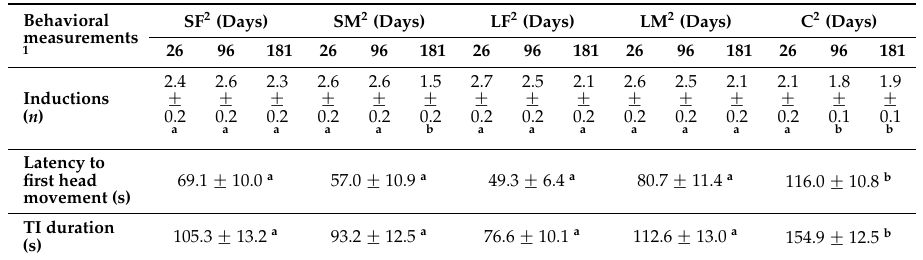
Table 3. Tonic immobility responses of layers when 26, 96 and 181 days